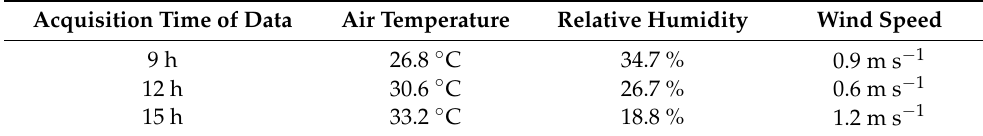
Table 2. Weather conditions at three times of data acquisition on 19 January 2017,